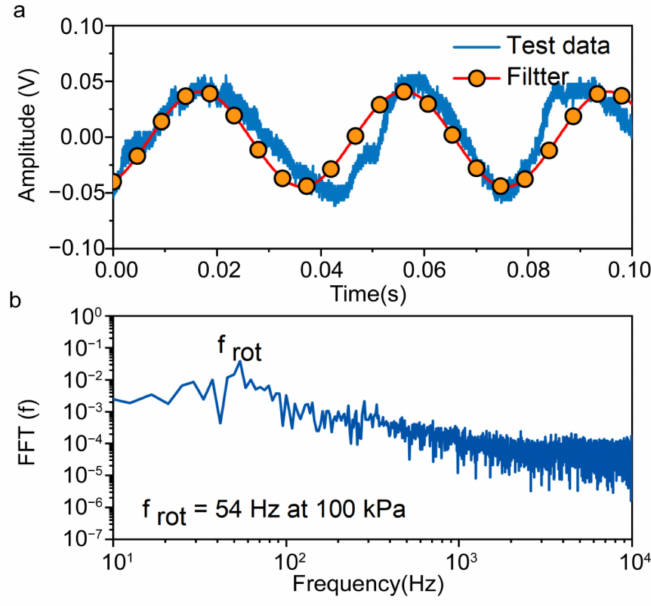
Figure 13. Test of rotation signal in the atmosphere. ( a ) Time domain signals; ( b ) Frequency domain signals.